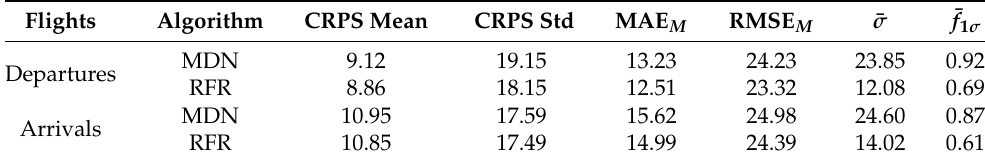
Table 4. Performance metrics for probabilistic flight delay